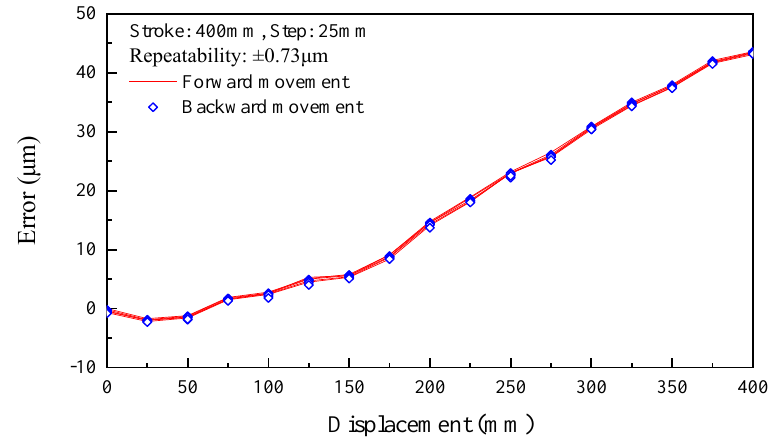
Figure 21. Repeatability. Figure 21.